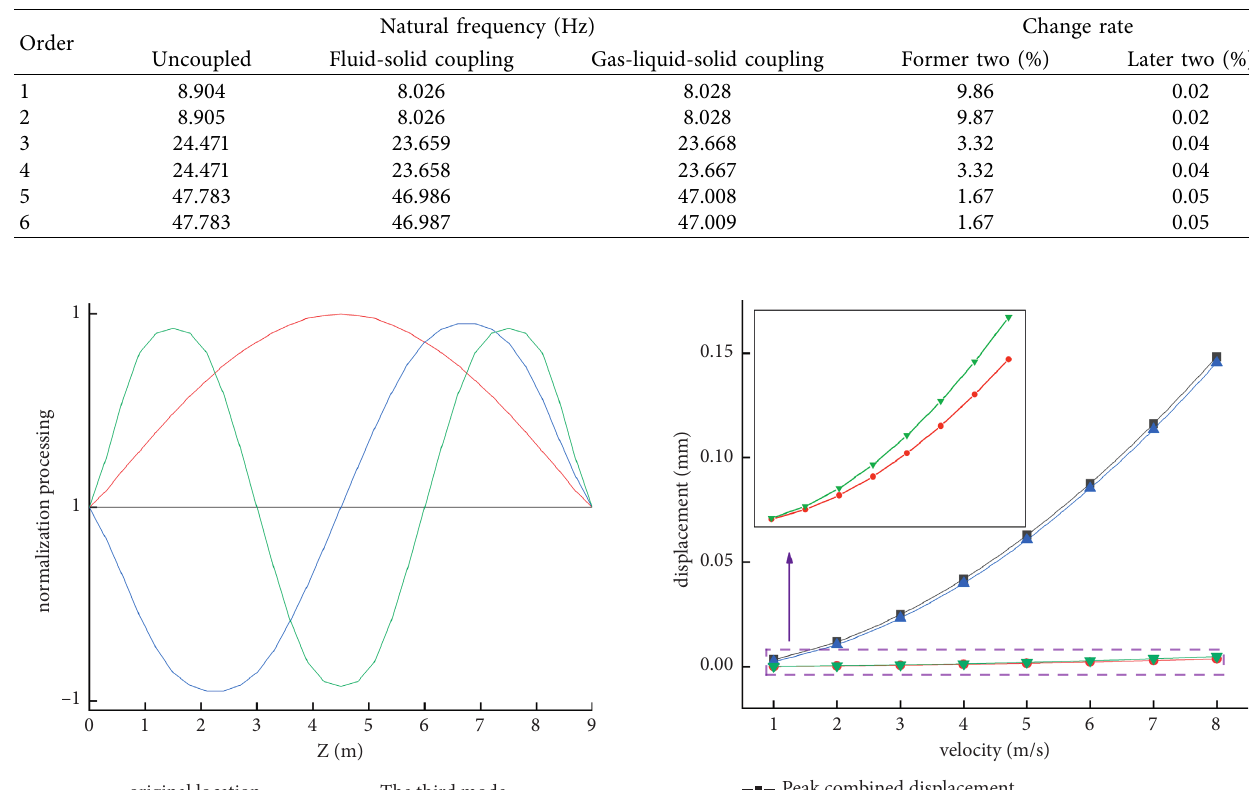
Table 3: The natural frequency of the drilling string under fluid-structure coupling.